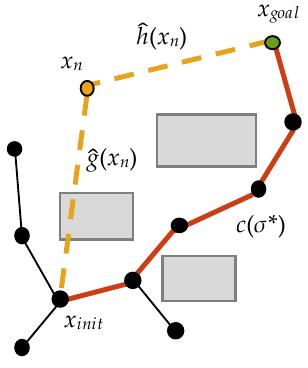
Figure 5. Tree construction.